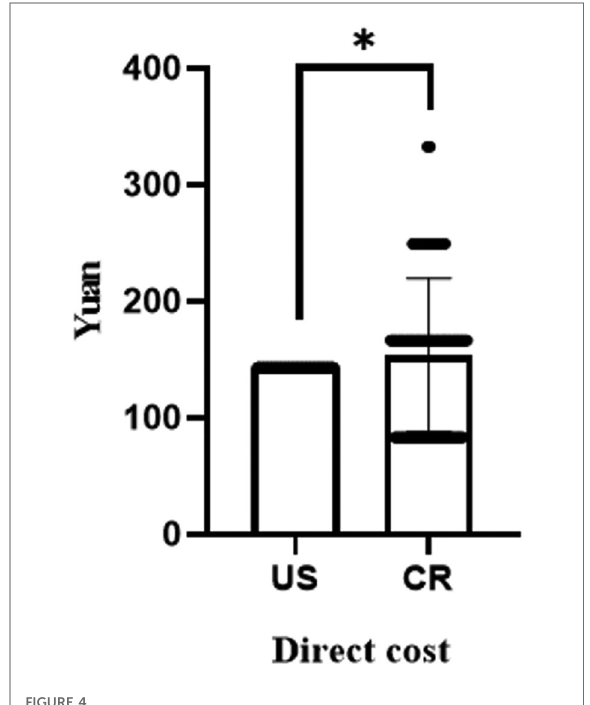
FIGURE 4 Comparison of direct cost between US and CR (* P